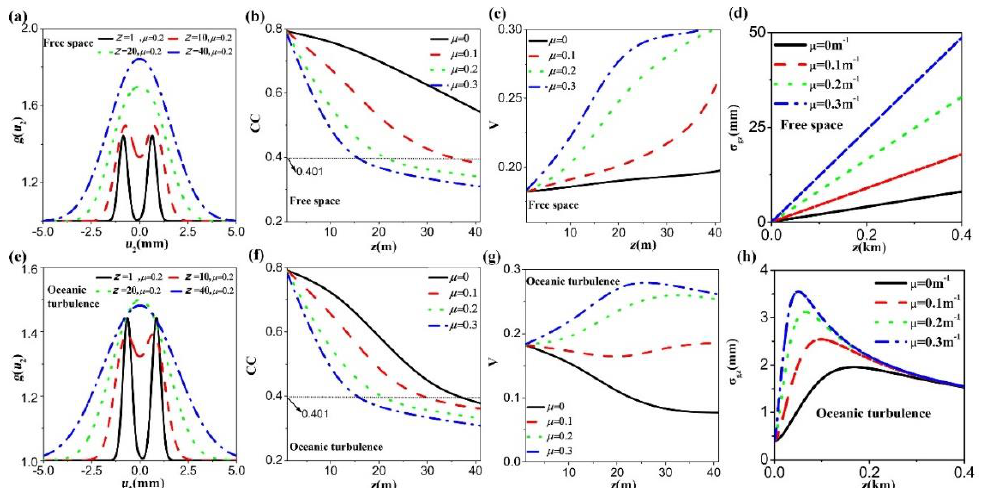
Figure 7. Image of double slits at several different propagation distances z (m) ( a ) in free space and ( e ) in oceanic turbulence. The variation of CC with the propagation distance ( b ) in free space and ( f ) in oceanic turbulence. The variation of visibility with the propagation distance ( c ) in free space and ( g ) in oceanic turbulence. Evolution of the coherence width with the propagation distance in turbulence at several values of twist factors ( d ) in free space and ( h ) in oceanic turbulence.